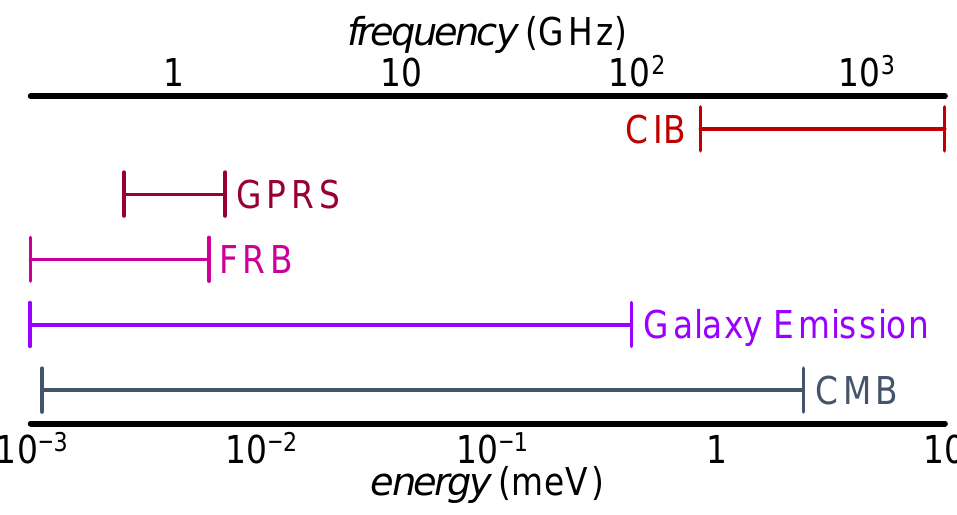
Figure 1. Frequency and energy ranges relevant for different GHz astronomical sources, such as cosmic infrared background (CIB), gigahertz-peaked radio sources (GPRS), fast radio bursts (FRB), emission from galaxies and cosmic microwave background